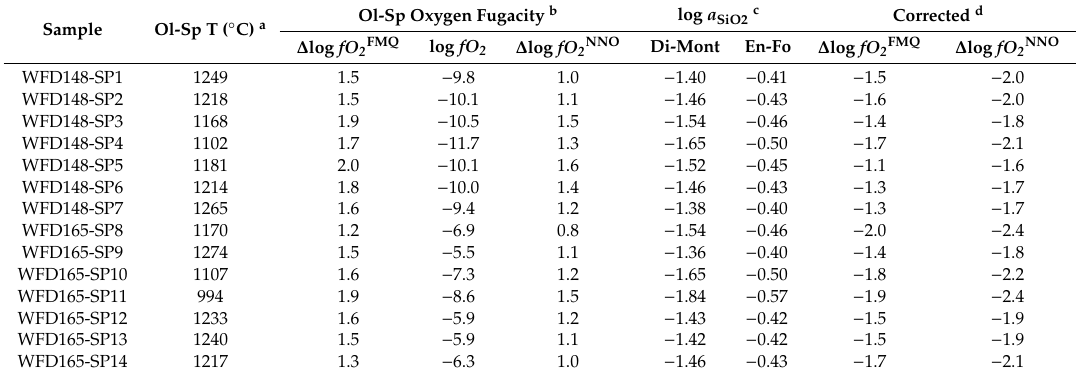
Table 3. Equilibrium temperatures and oxygen fugacities estimated for the No.30 kimberlite magma by Ol-Sp thermobarometry assuming a pressure of 1 GPa. Ol-Sp Oxygen Fugacity b log a SiO2 Sample Ol-Sp T ( ◦ C) a